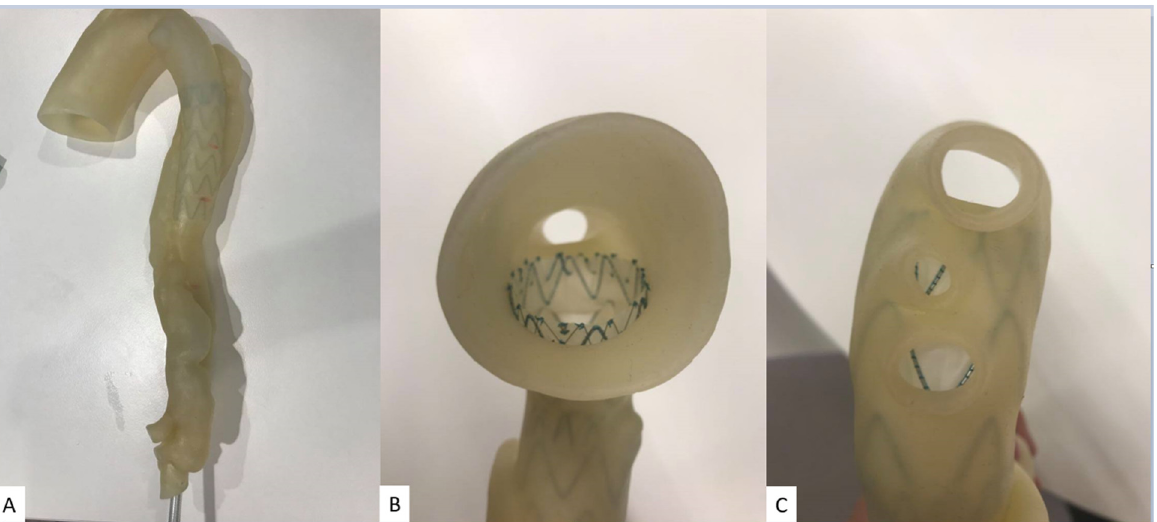
Figure 3. Stent graft deployed in 3D printed model. The aortic model was printed with Visijet CE-NT A30. ( A ): Deployed stent graft visible through model wall. ( B ): Axial view from proximal aortic arch. ( C ): Caudal view down aortic arch vessels. Reprinted with permission under the open access from Wu et al. [25].